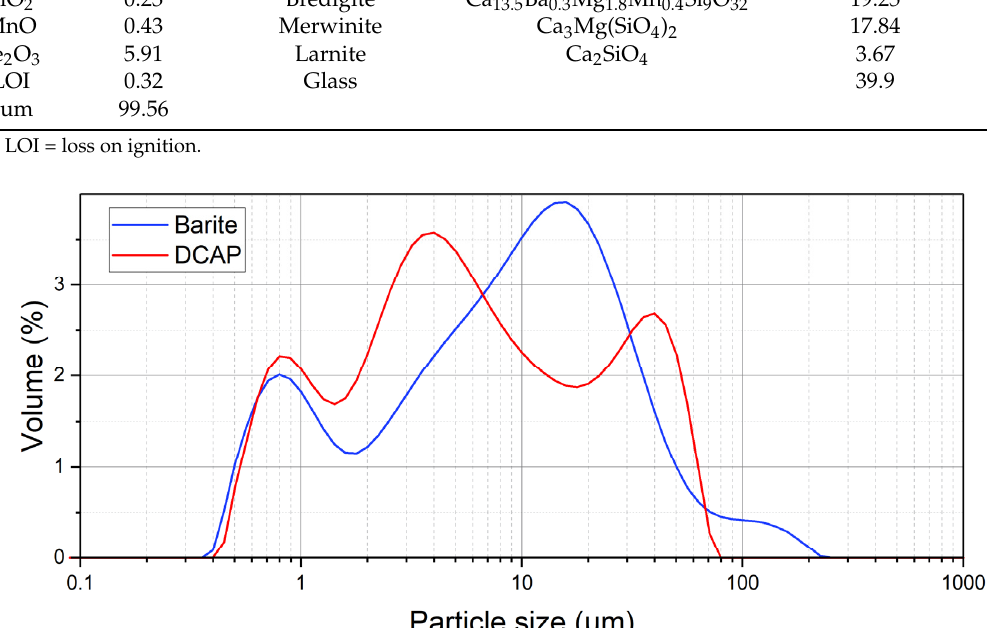
Figure 1. DLS grain size distribution of DCAP [2] and barite (this work). Table 2. Bulk chemical and mineralogical compositions of DCAP (from Vergani et al. 2021 [2]).